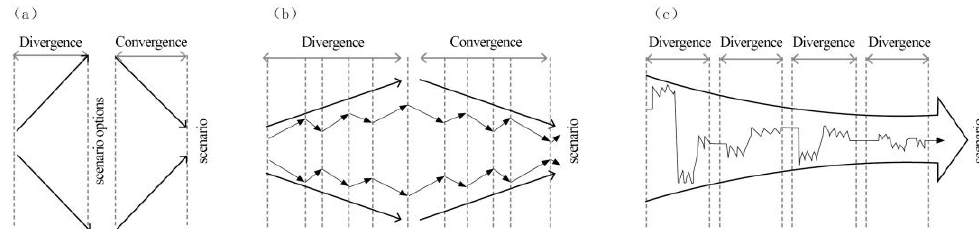
Figure1. ( a ): divergentandconvergentstage; ( b ): repetitionofdivergenceandconvergence; ( c ):scenario Figure 1. (a): divergent and convergent stage; (b): repetition of divergence and convergence; (c): exploration scenario exploration process.